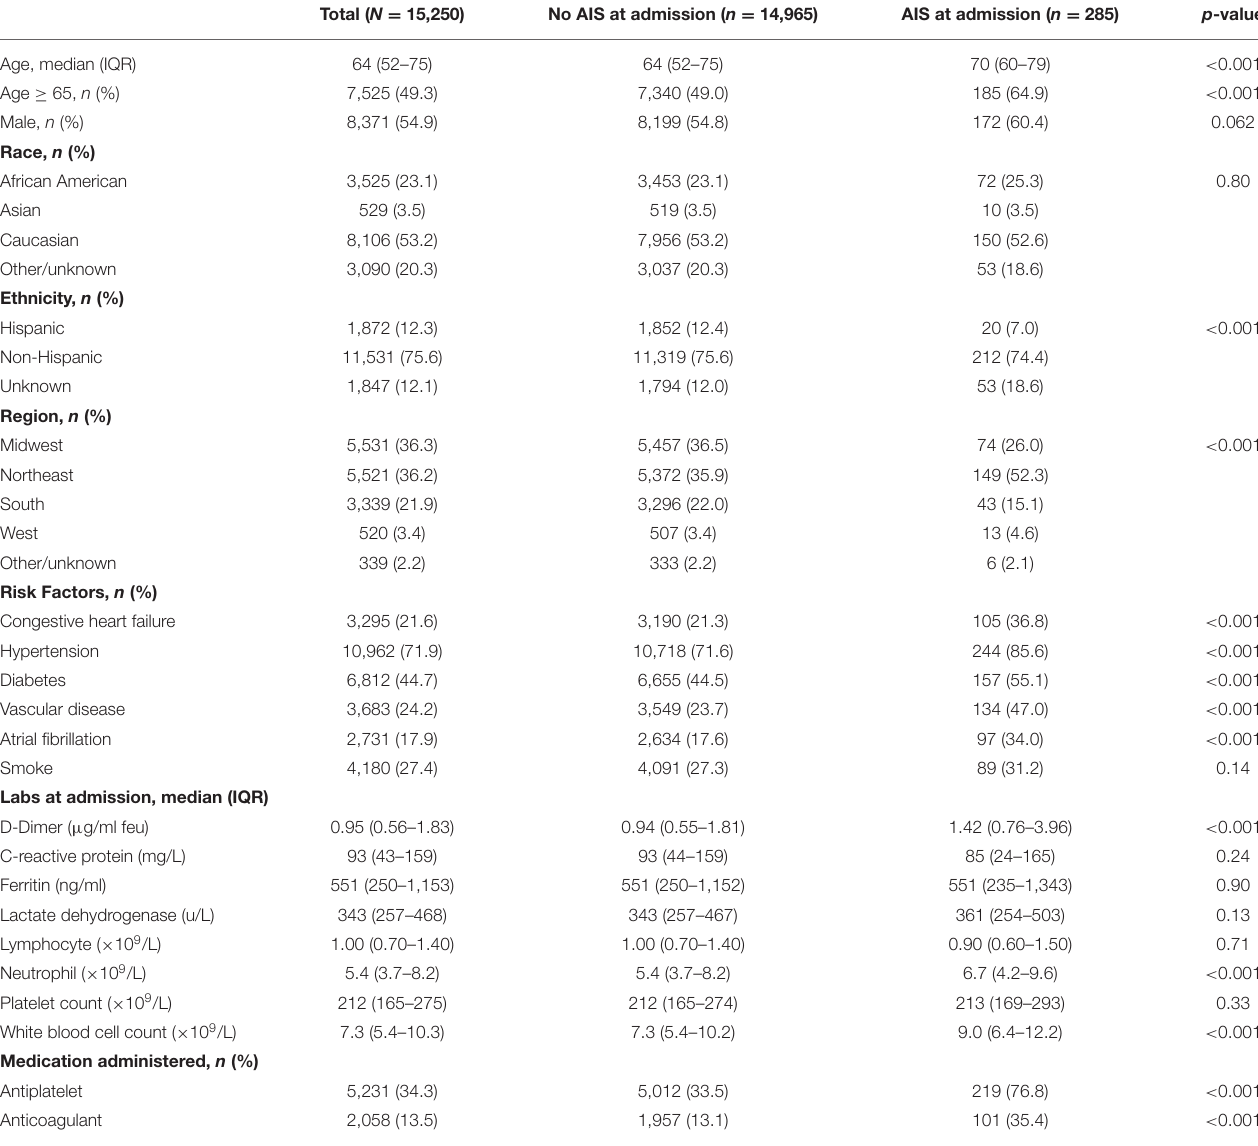
TABLE 1 | Characteristics of patients in COVID with or without acute ischemic